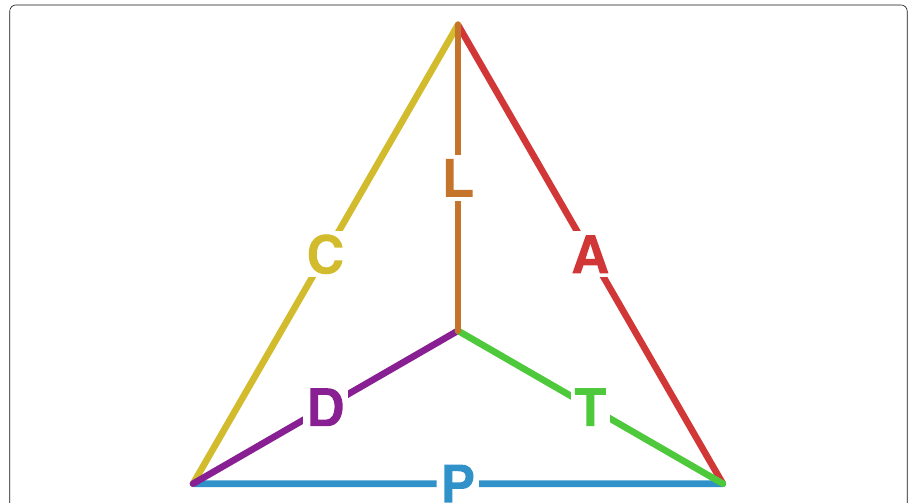
Fig. 5 Tetrahedral graph of demographic time hexad identity, with edges labelled by the six time indices